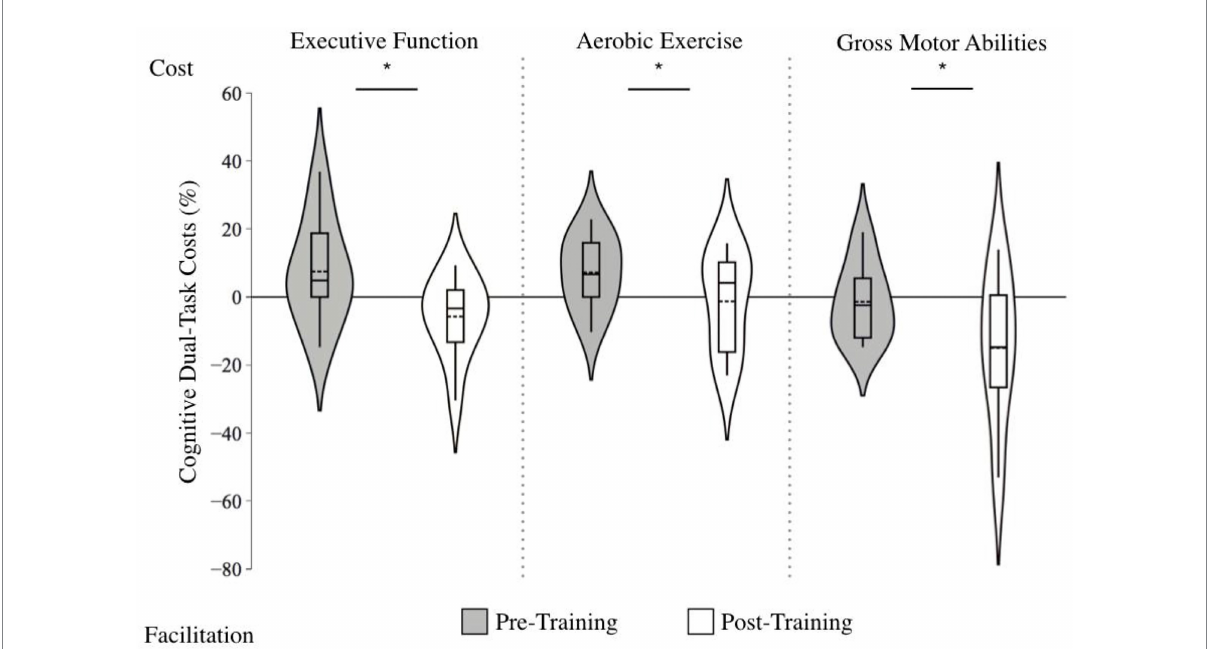
FIGURE 2 Violin plot of cognitive dual-task costs before and after training across training groups. Note: Positive scores indicate greater dual-task costs (i.e., lower 2-back accuracy during dual-tasking compared to single tasking), whereas negative scores indicate dual-task facilitation (i.e., higher 2-back accuracy during dual-task compared to single task). The length of each curve represents the range of scores, the width represents the frequency of data points in each region, the solid line within each boxplot represents the median, and the dotted line represent the mean. Following training, cognitive accuracy dual-task costs improved, regardless of the training protocol ( g = −